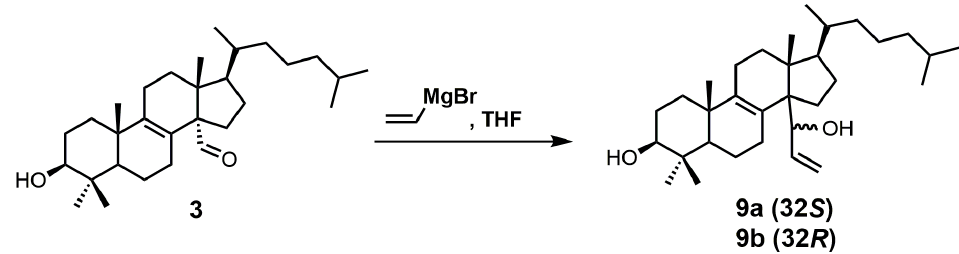
Figure 8. The synthesis of 4,4-dimethyl-14 α -(1 ′ hydroxy-2 ′ -vinyl)-5 α -cholest-8-en-3 β -ols.